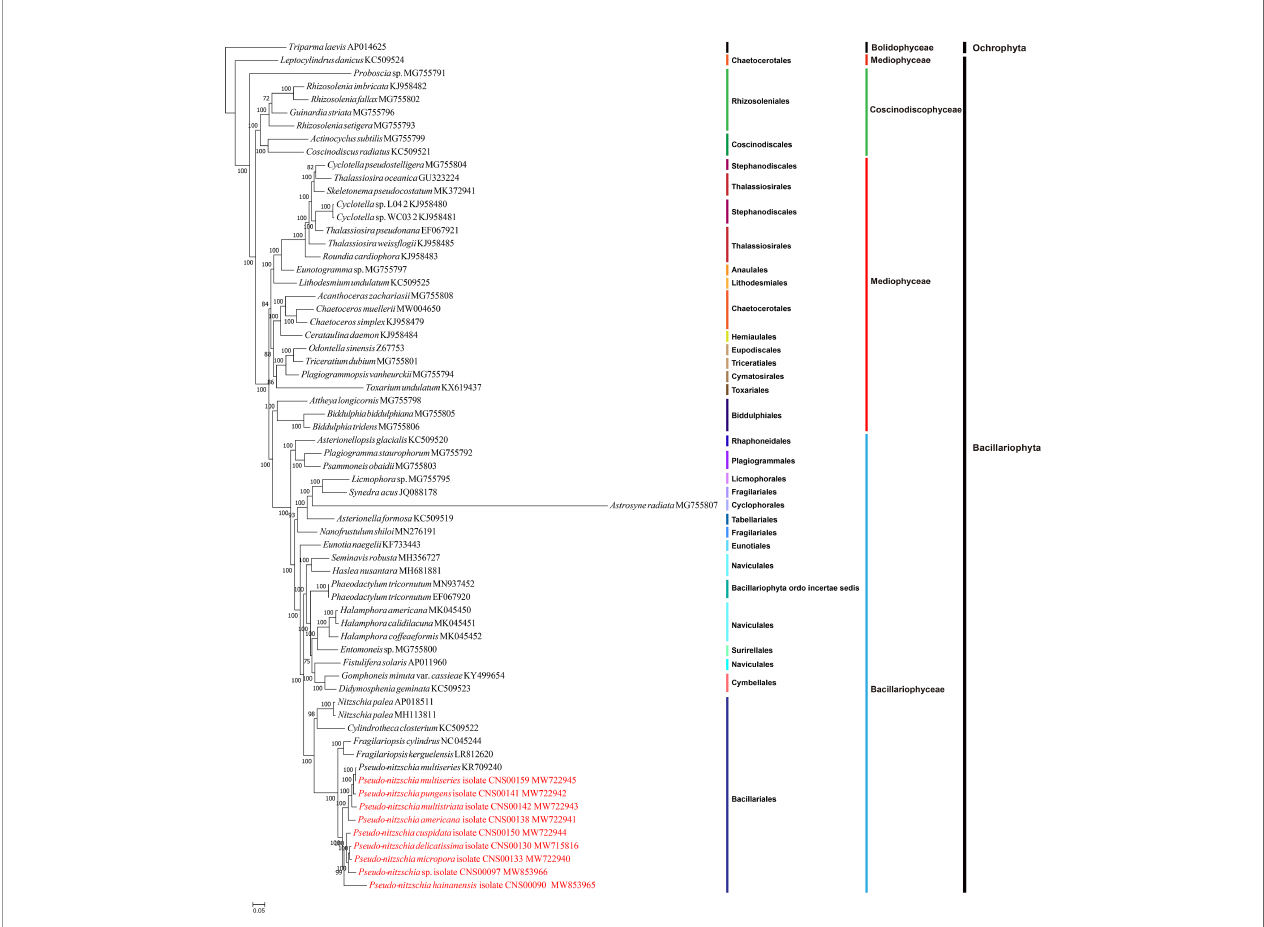
FIGURE 3 | Maximum likelihood (ML) phylogenetic tree based on tandem amino acid sequences of 95 common PCGs from 65 cpDNAs, including 55 previously published Bacillariophyta cpDNAs, nine Pseudo-nitzschia cpDNAs constructed in this study, and Triparma laevis (AP014625) (an Ochrophyta chloroplast genome used as an outgroup taxa). Numbers at the branches represent bootstrap values.